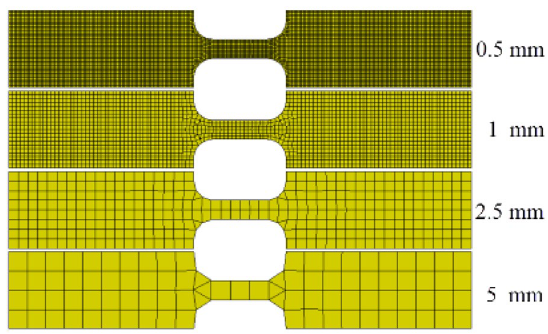
Figure 11 Finite element models of different mesh